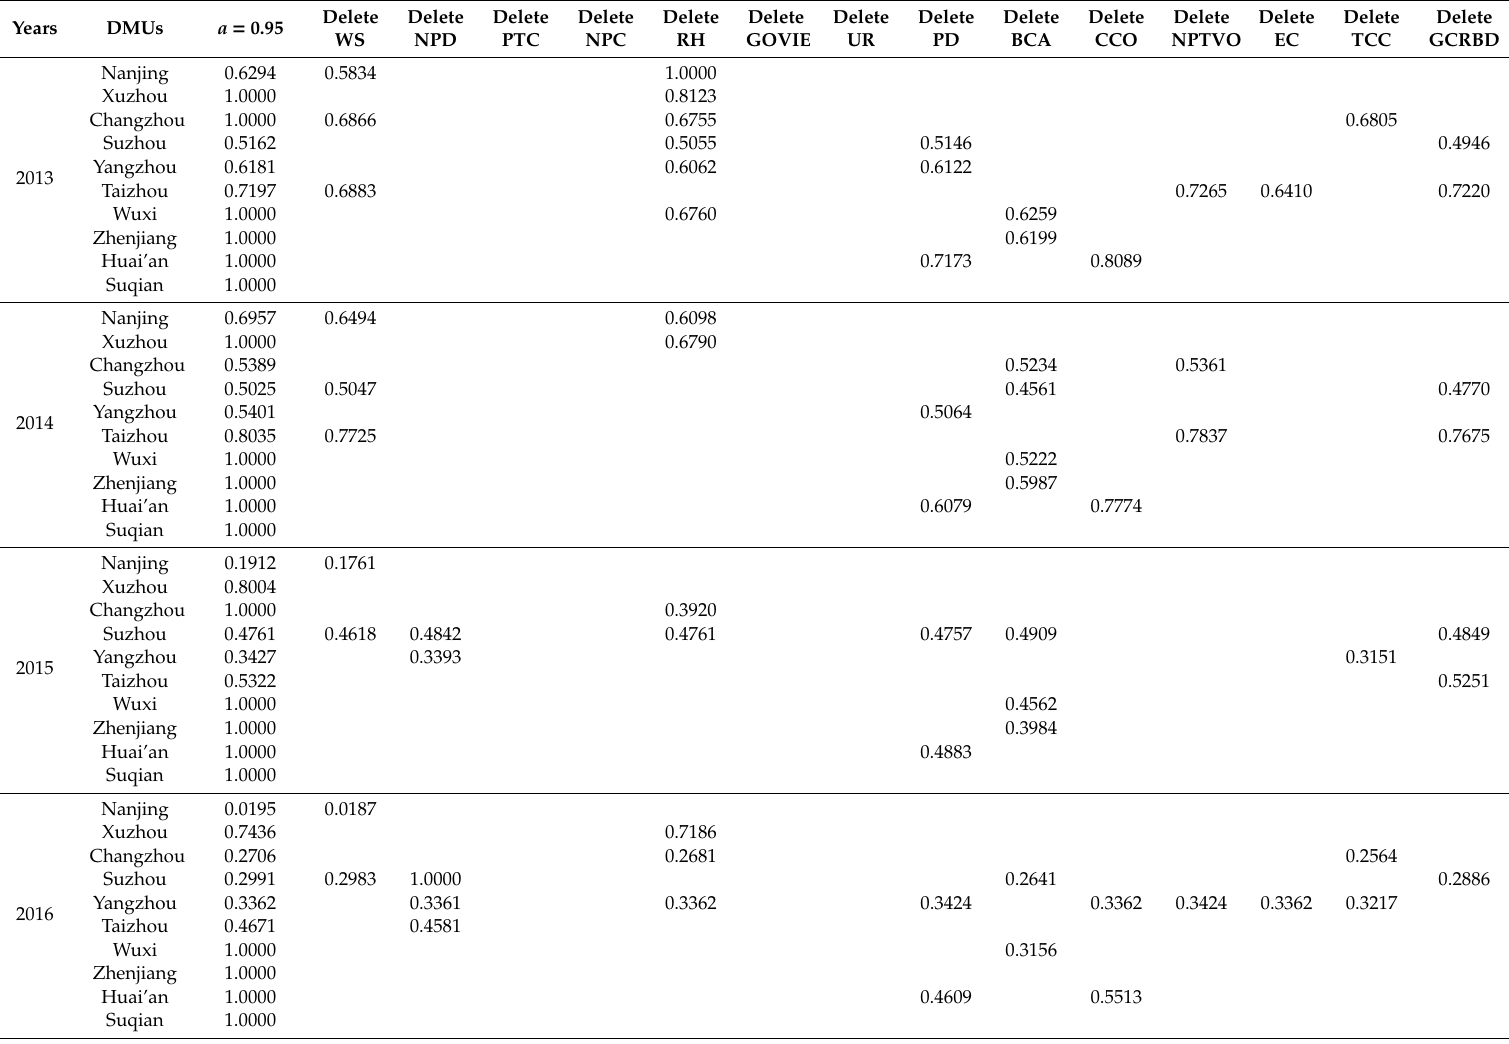
Table A17. The changes of stochastic e ffi ciency value by deleting single input variable in Inland Area ( α =